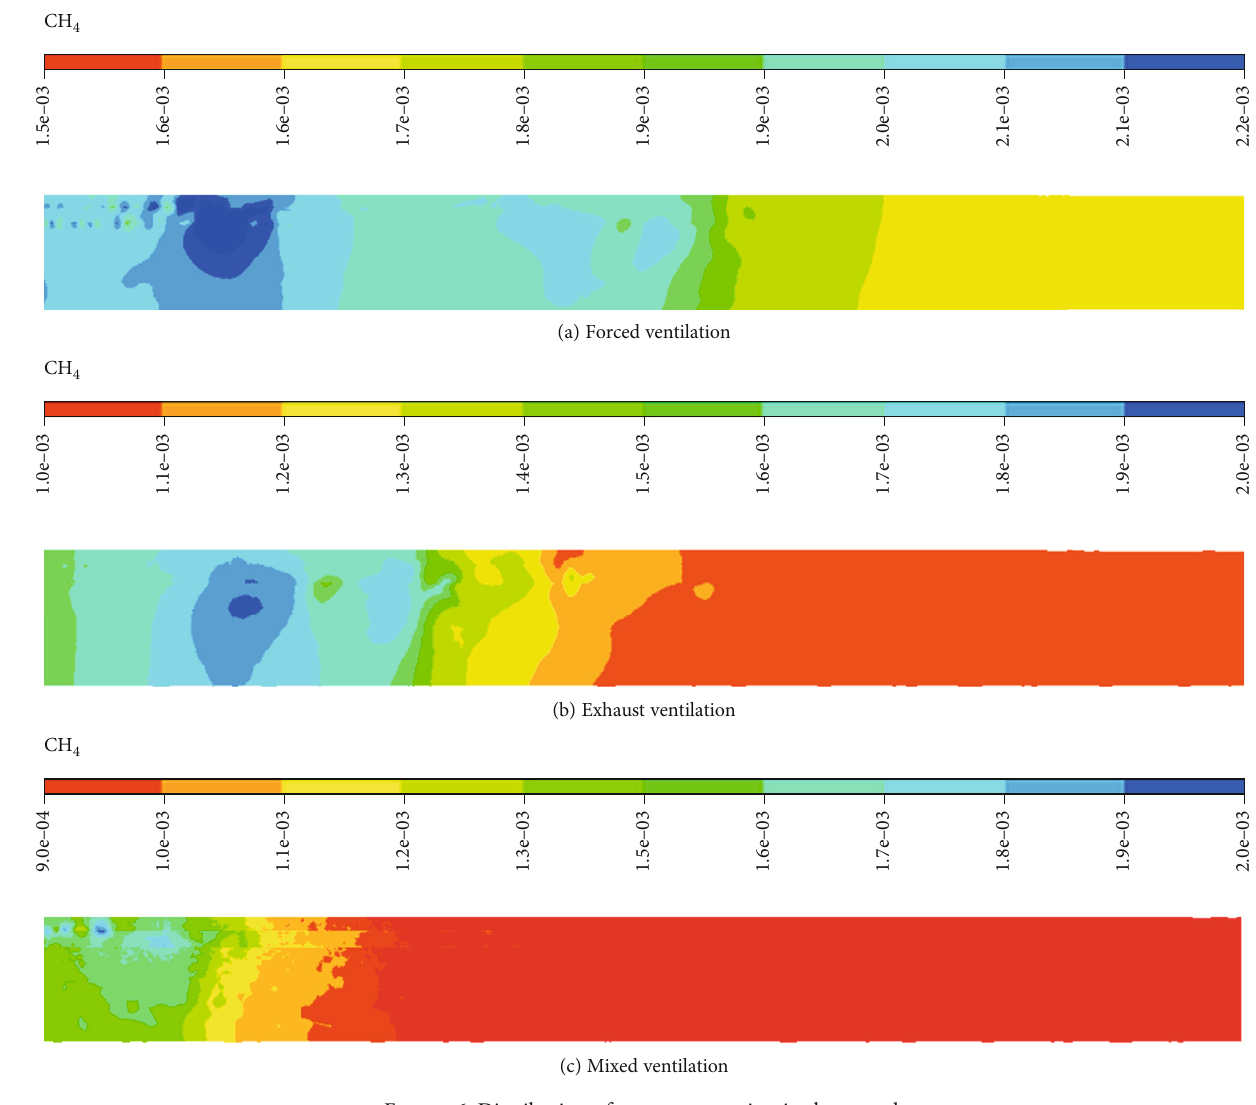
Figure 6: Distribution of gas concentration in the